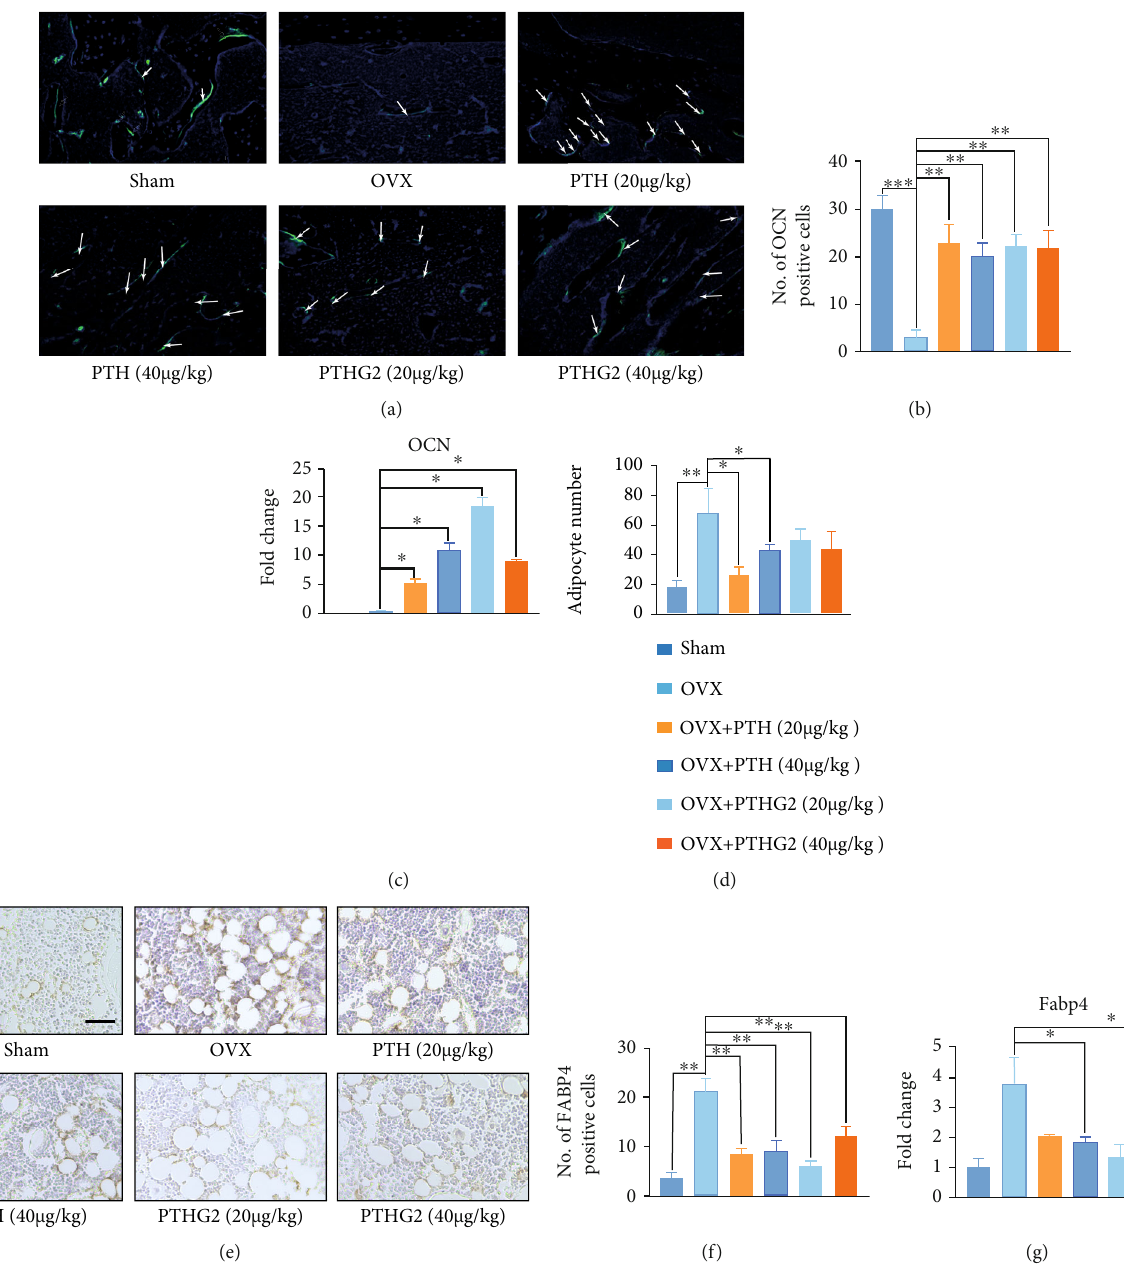
Figure 3: PTHG2 protects the reduced osteoblast activity induced by OVX and weakens the formation of bone marrow adipocytes. (a) Representative images for immuno fl uorescence assay of osteocalcin (OCN). (b) Quantitative positive cells of OCN. (c) The relative expression of osteoblast marker gene (OCN) following PTHG2 treatment was quanti fi ed by real-time PCR. (d) Quantitative lipid droplets of H&E staining. (e) Representative images for immunohistochemistry assay of Fabp4 and (f) quantity. (g) The relative expression of adipocyte marker gene (Fabp4) following PTHG2 treatment was quanti fi ed by real-time PCR. Values presented as the mean ± standard deviation ( n = 3 ); scale bar, 50 μ m; ∗ p < 0 : 05 , ∗∗ p < 0 : 01 , ∗∗∗ p < 0 : 001 , ∗∗∗∗ p < 0 : 001